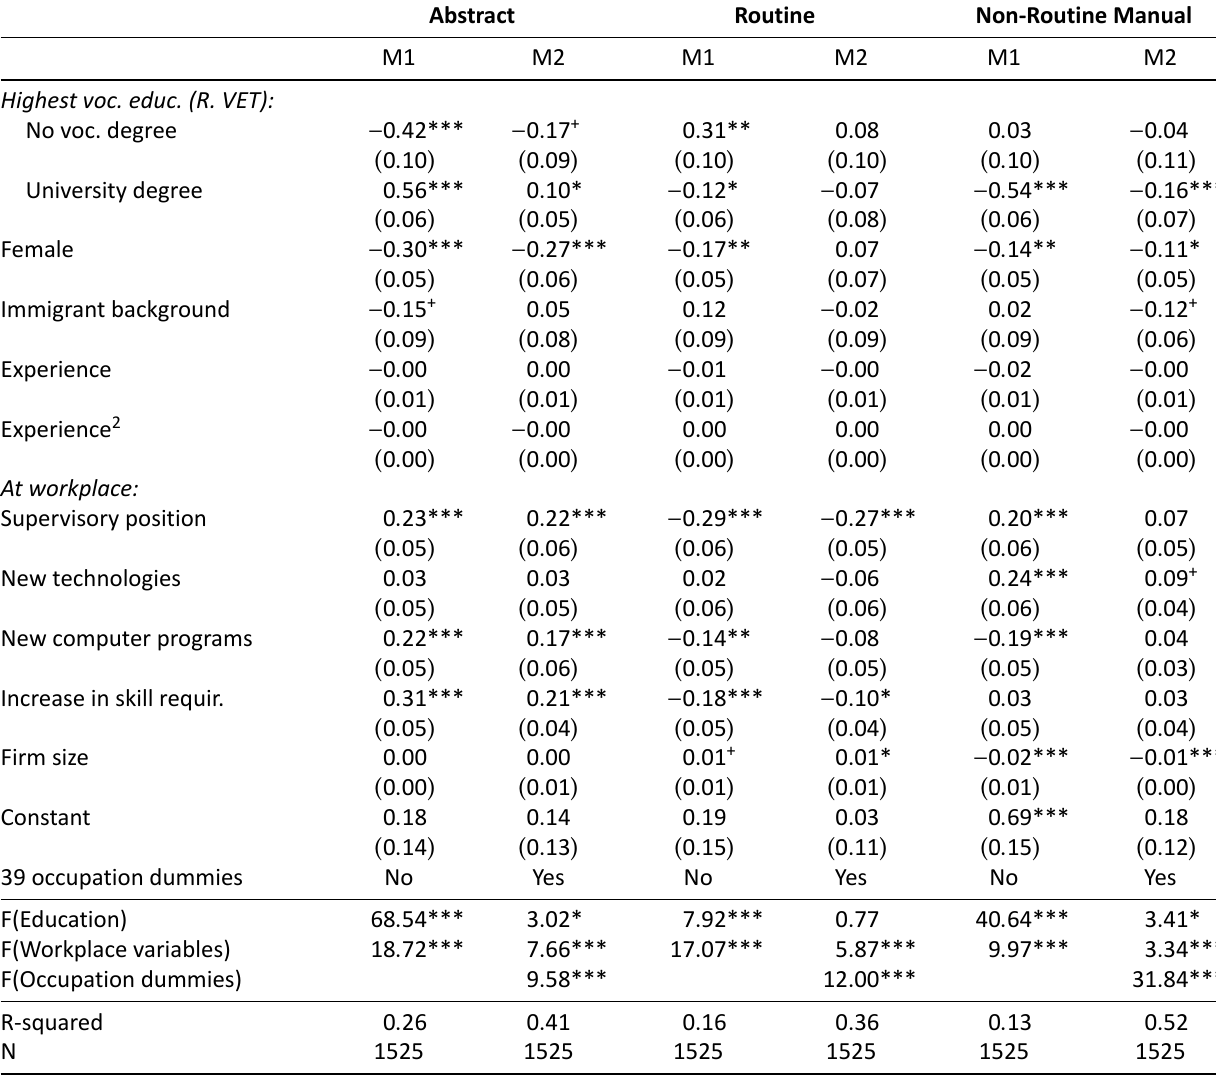
Table A1. OLS-Regressions of abstract, routine, and non-routine manual tasks without/with occupation fixed effects for occupations with n 20. Source: BIBB/BAuA Employment Survey 2012 and Supplemental Task Survey to the Employment i ≥ Survey